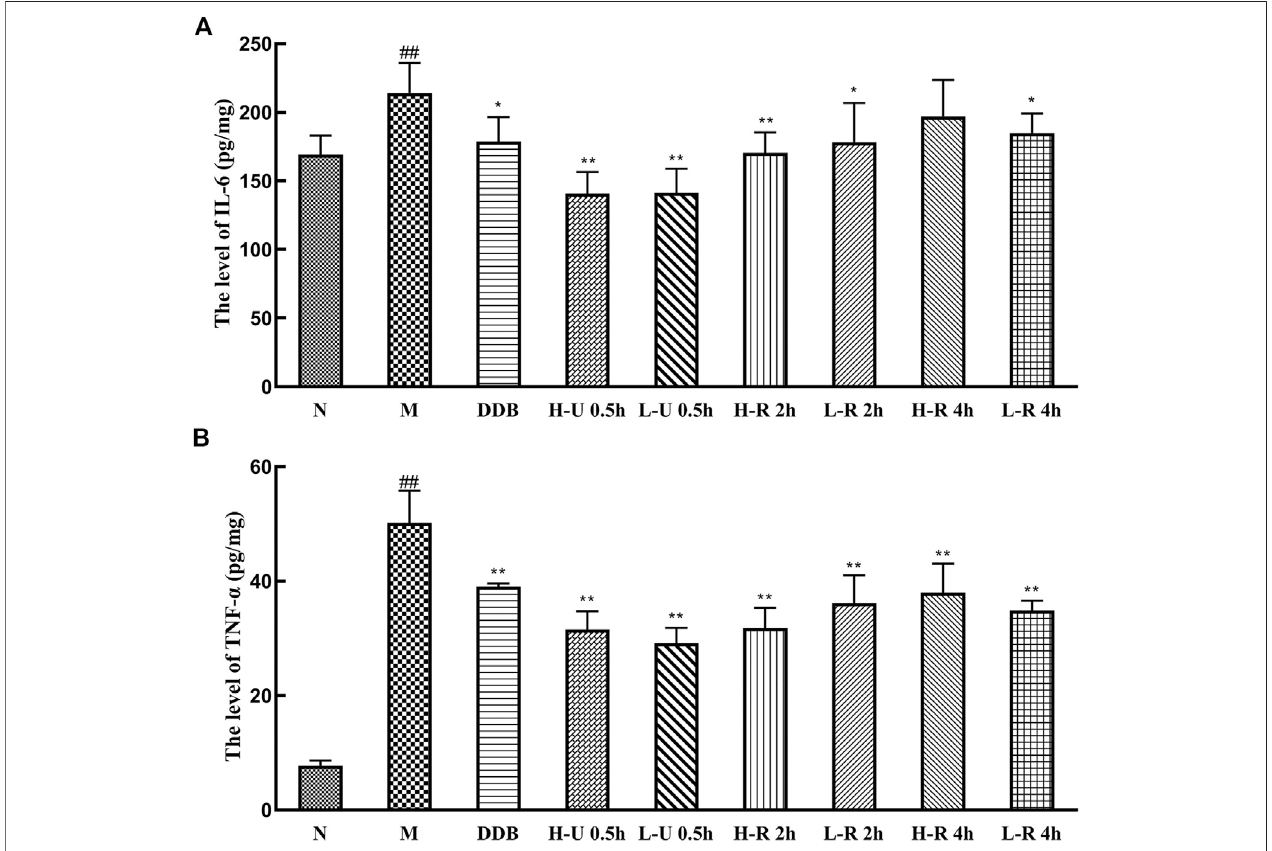
FIGURE 6 | Comparison of liver levels of IL-6 (A) , TNF- α (B) ( x ± s, n (cid:1) 6). Compared with group N, # p < 0.05, ## p < 0.01; compared with group M, * p < 0.05, ** p < 0.01.